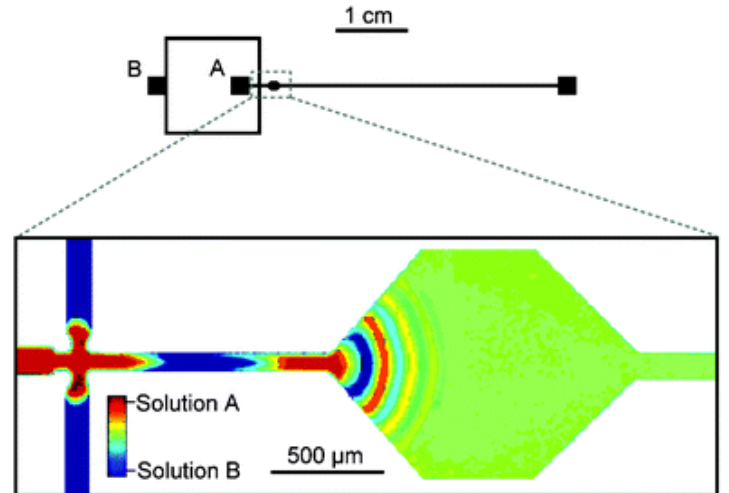
Figure 9. An alternate-injection mixer composed of an inlet cross channel and a larger chamber (from Coleman et al.